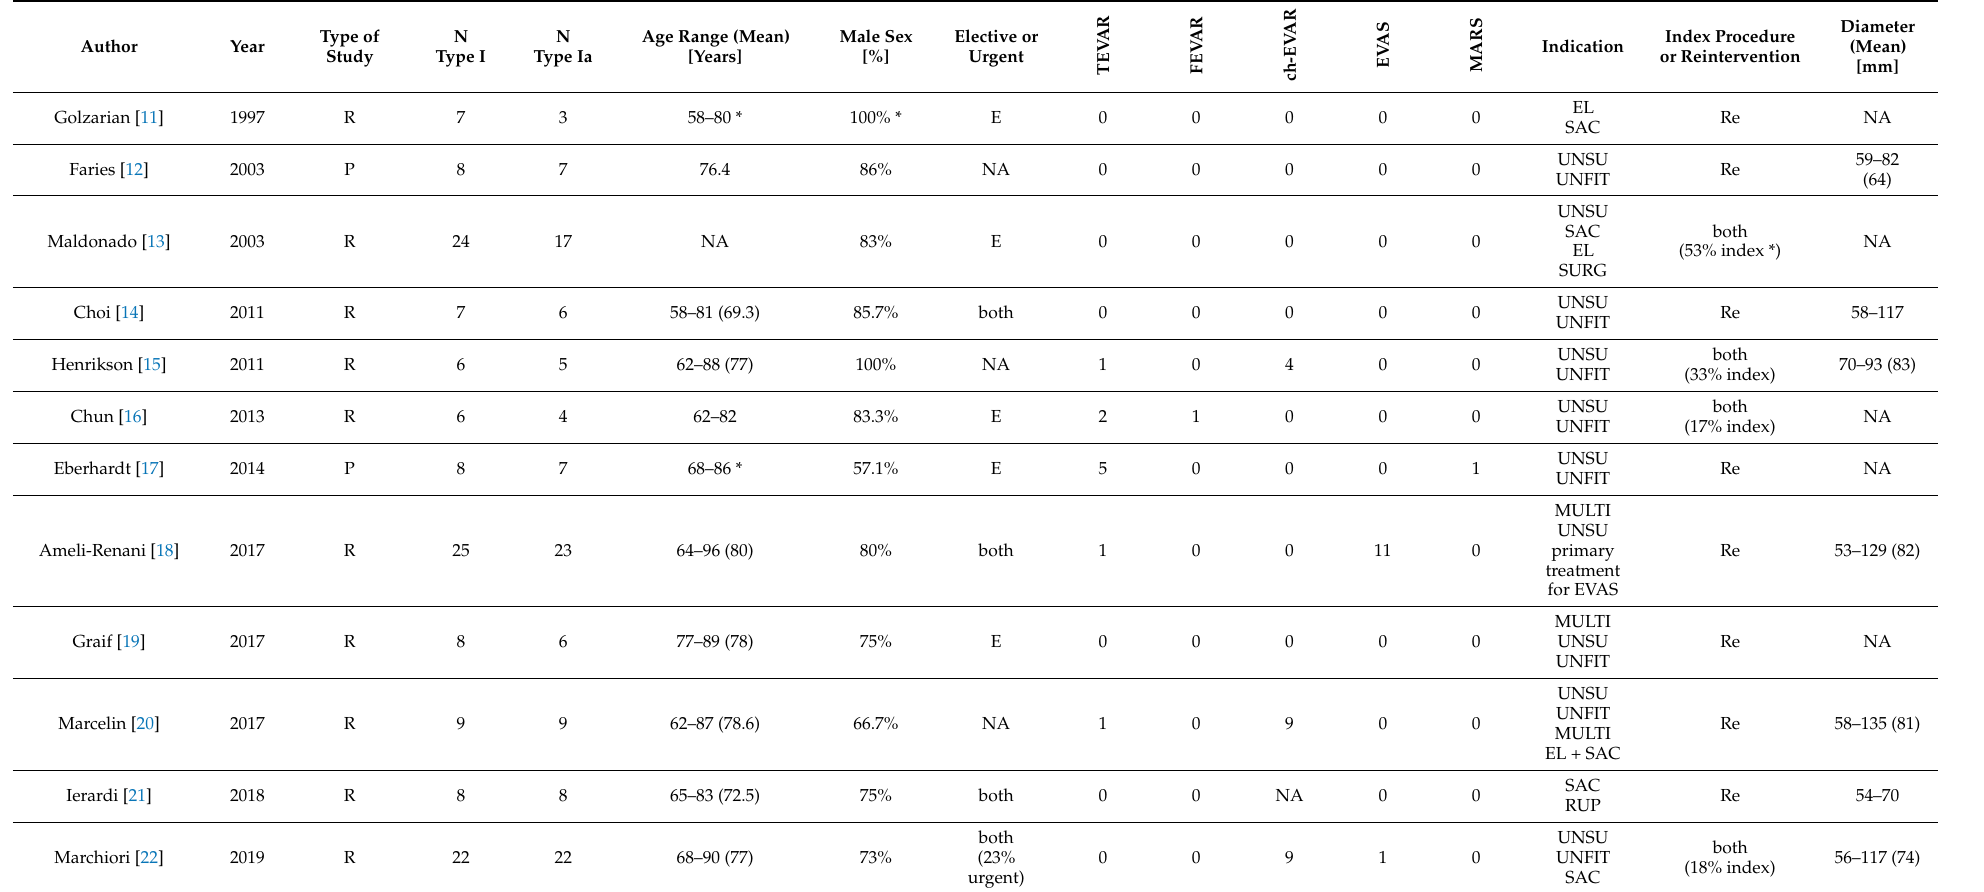
Table 1. Baseline data on included case series: type of study, patient demographics and indication for